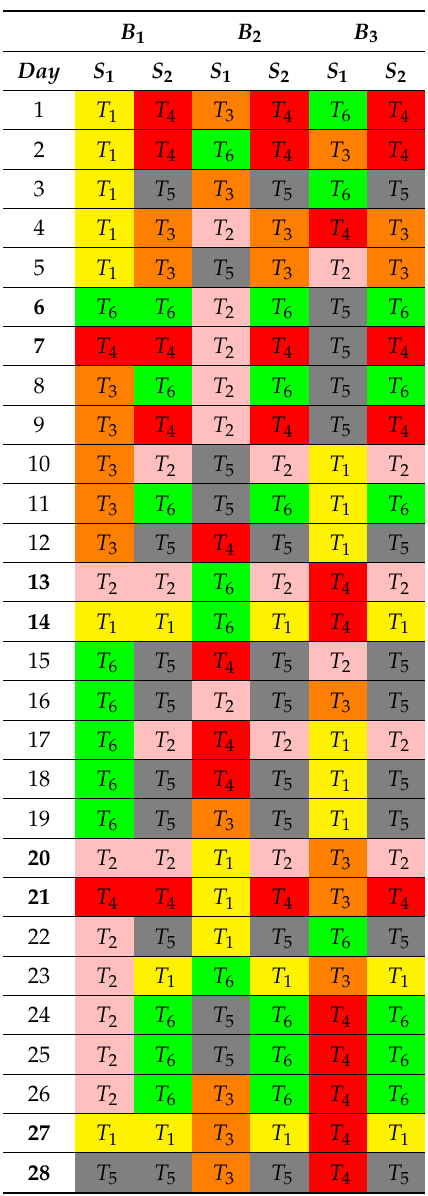
Table 3. Optimized physician schedule for